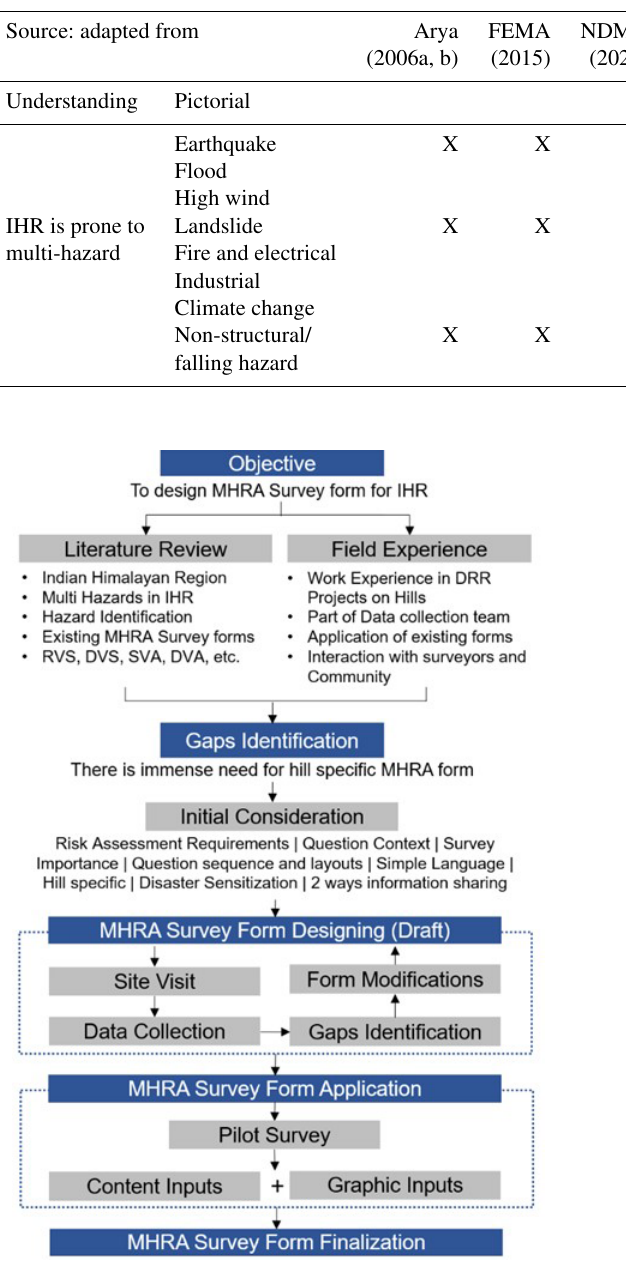
Table 2. Comparison between survey forms used in India to assess risk. SN Developed by/for